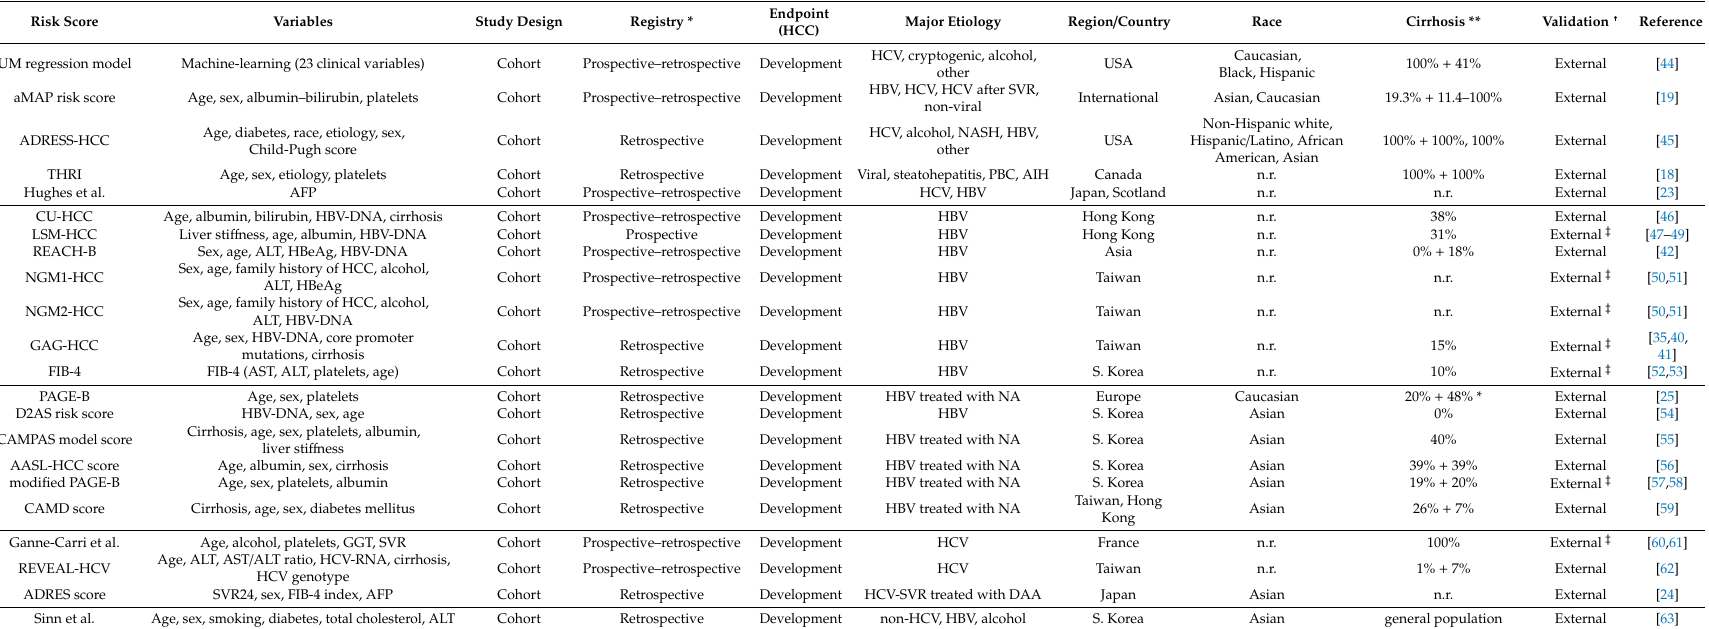
Table 1. Clinical HCC risk scores.